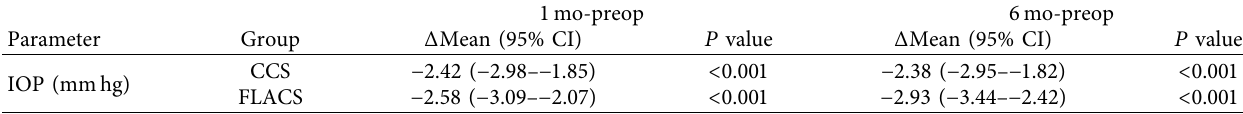
Table 2: Diference between postoperative and preoperative IOP in CCS and FLACS groups. 1mo-preop